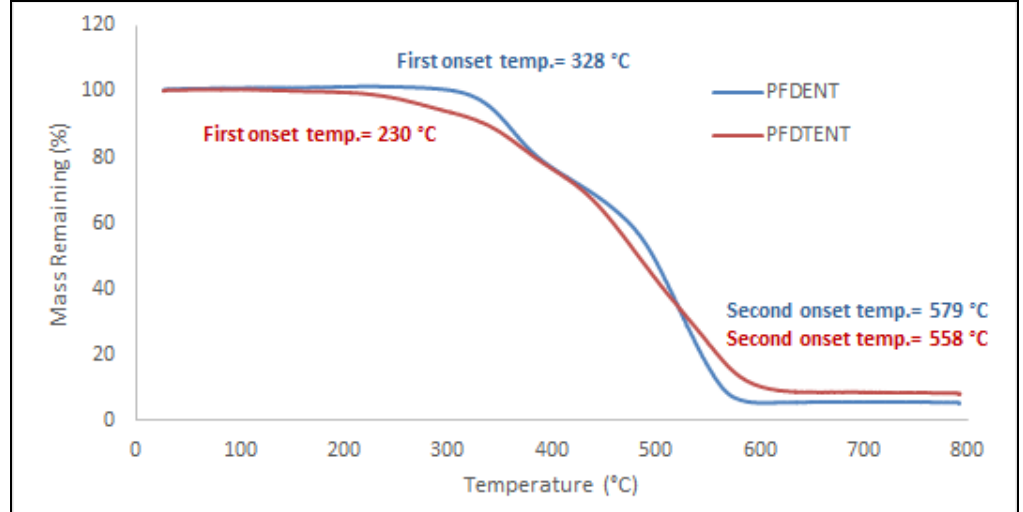
Figure 4. TGA plots of the resulting polymers with a heating rate of 10 °C/min under N